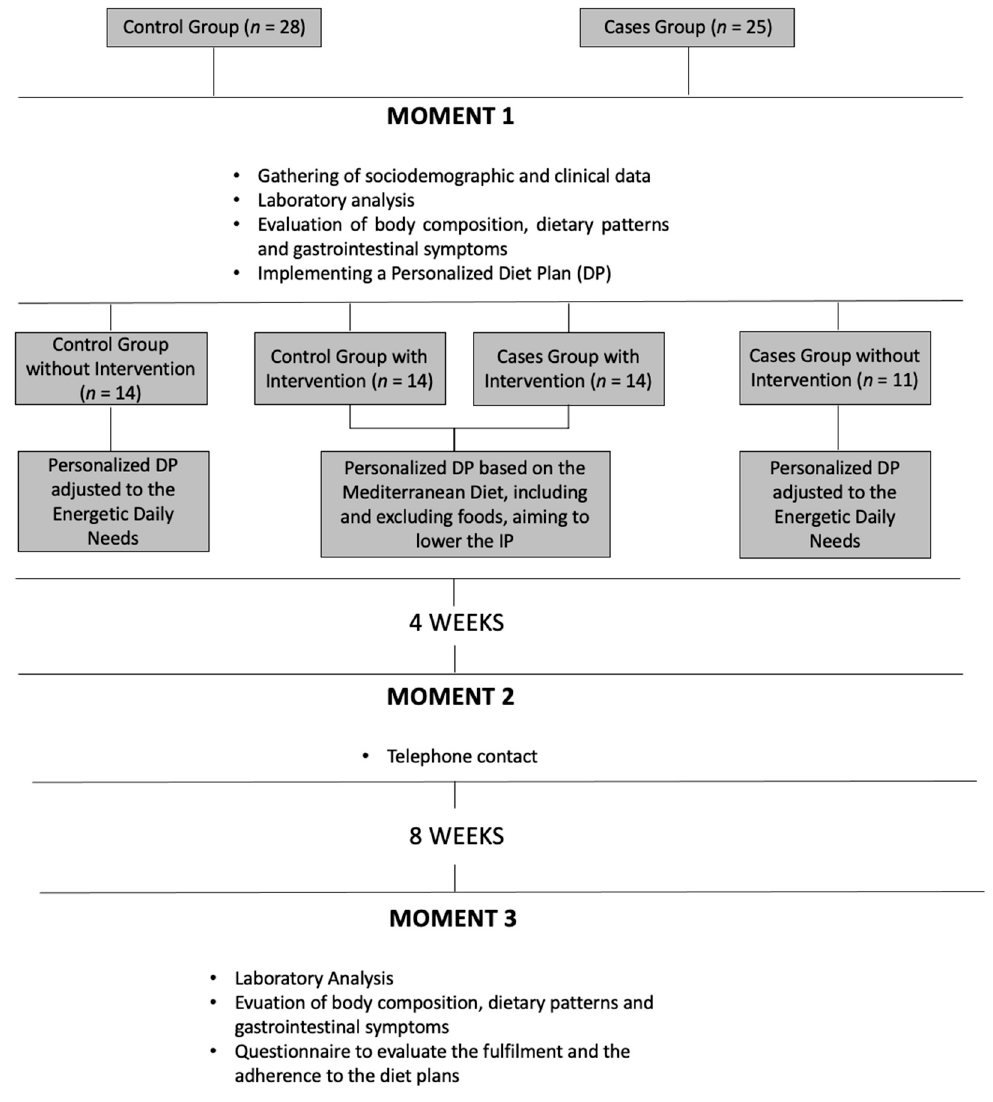
Figure 1. Study design and methodology.